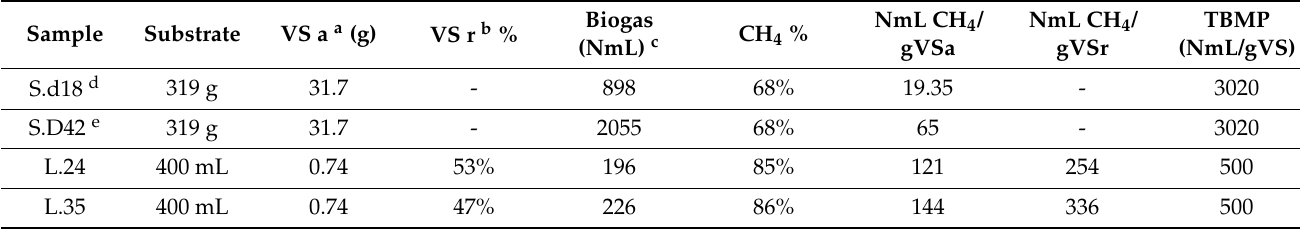
Table 7. Summary of findings from biomethane potential